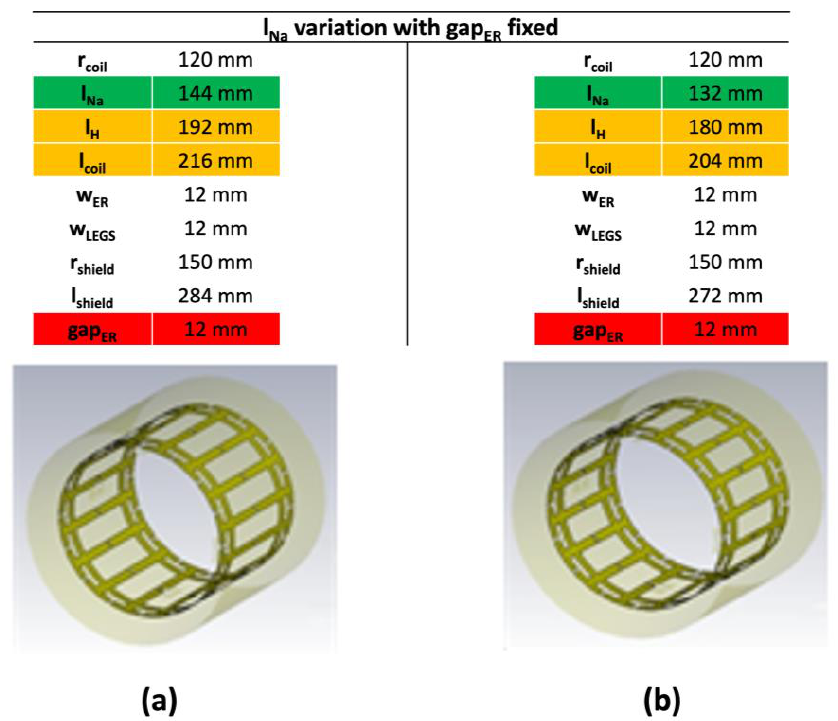
Figure 4. EM CAD model of the four-ring DT-RF coil model versus the geometrical dimensions. The l Na variable parameter is in green, while the parameters changing with the l Na parameter are in orange (l H and l coil ). In red are the fixed parameters (gap ER ).